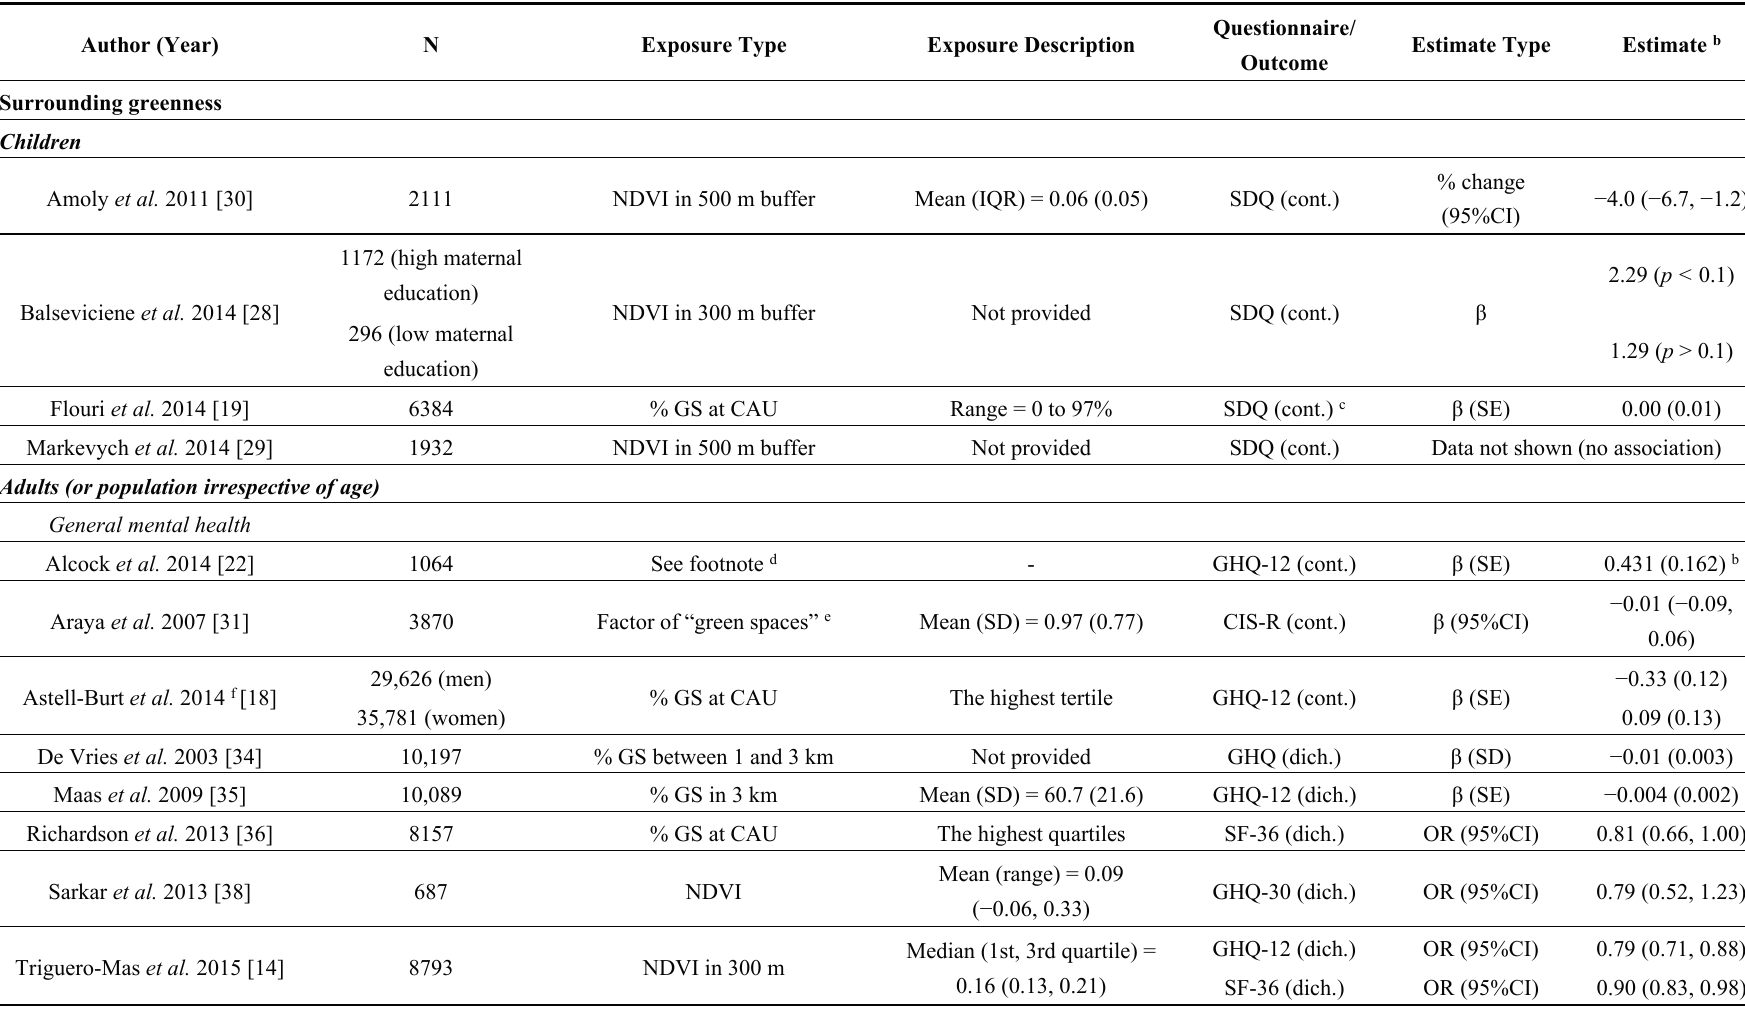
Table 3. Main estimations of the association between surrounding greenness or access to green space and mental health a (results presented by exposure type, children/adults and then outcome type) a